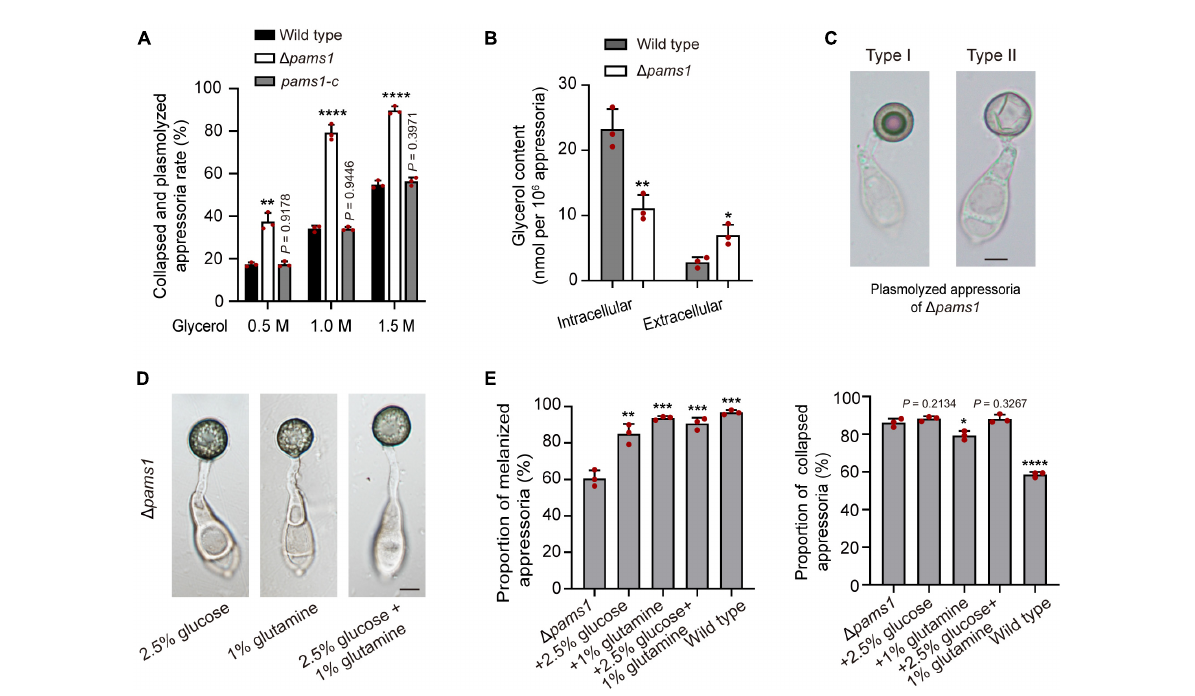
FIGURE9 Roles of Pams1 in appressorium cell walls. (A) Incipient cytorrhysis assays for appressorium turgor pressure ( n = 3). The appressoria at 24 hpi were incubated in 0.5, 1.0, or 1.5 M of glycerol solutions, and the collapsed and plasmolyzed appressoria were counted under a microscope. At least 140 appressoria were counted per replicate. (B) Intracellular and extracellular glycerol contents of appressoria formed by the wild type and (cid:49) pams1 on hydrophobic polyvinyl chloride (PVC) films at 24 hpi ( n = 3). (C) Plasmolyzed appressoria (types I and II) formed by (cid:49) pams1 at 24 hpi and incubated in a 1.5 M glycerol solution. (D) Appressoria were formed by (cid:49) pams1 after the addition of exogenous glucose and/or glutamine at 24 hpi. (E) Addition of exogenous 2.5% glucose and/or 1% glutamine obviously increased the number of melanized appressoria (Left panel) but did not greatly increase appressorium turgor pressure (Right panel) in (cid:49) pams1 ( n = 3). Appressorium turgor pressure was assayed in a 1.5 M glycerol solution. At least 200 appressoria at 24 hpi were counted per replicate. Unpaired two-tailed Student’s t -test was used for comparisons with non-treated (cid:49) pams1 in panel (E) or with the wild type in panels (A,B) . * P < 0.05, ** P < 0.01, *** P < 0.001, **** P < 0.0001. (C,D) Scale bars, 5 µ